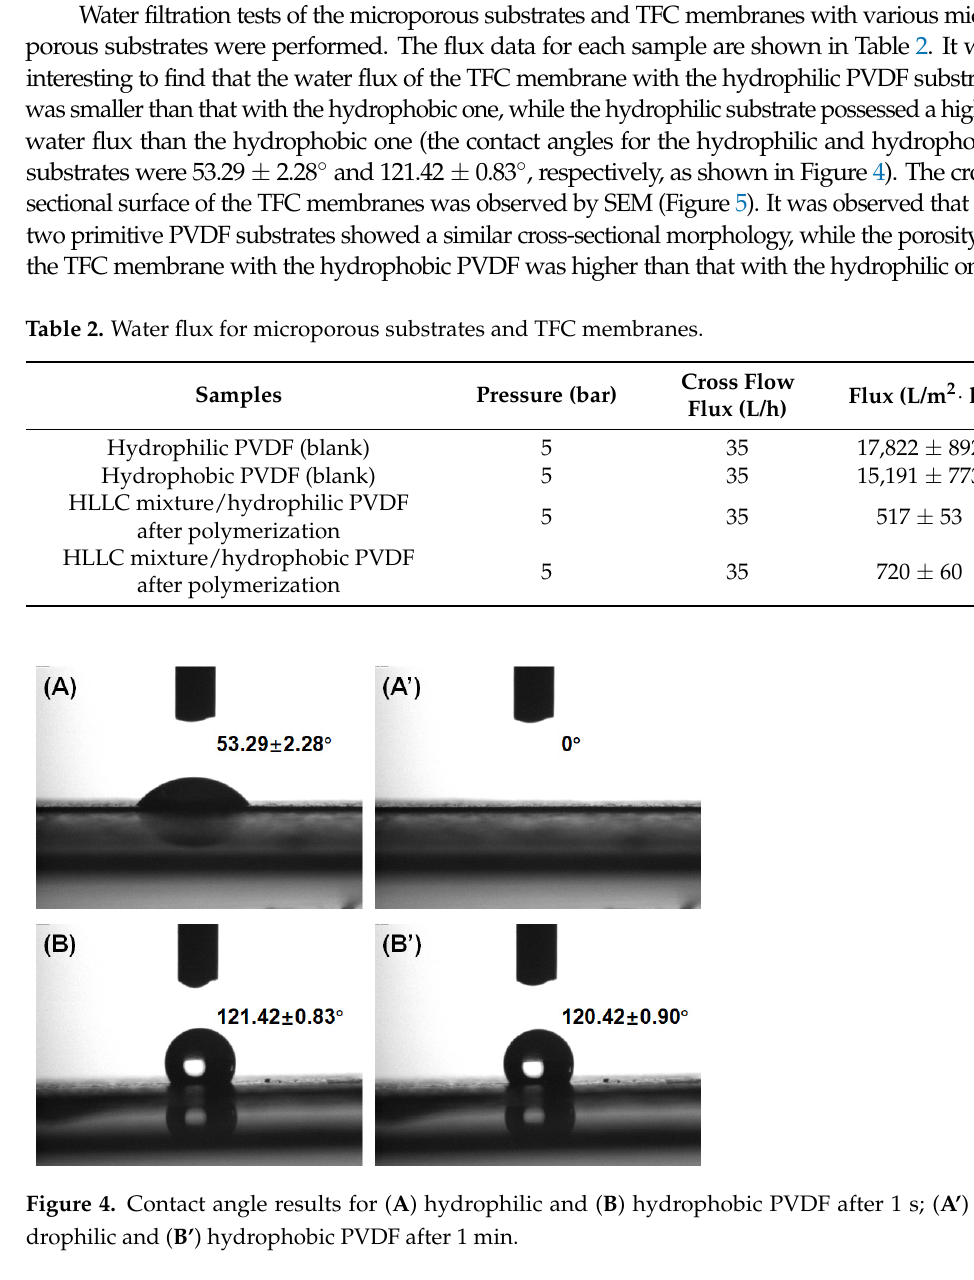
Figure 5. Scanning electron micrographs of HLLC mixture on ( A ) hydrophilic and ( B ) hydropho- bic PVDF after polymerization; ( A’ , B’ ) are primitive hydrophilic and hydrophobic PVDF sub- strates, respectively. 3.3. Discussion In general, the pore size, surface hydrophilicity, thickness, and porosity determined the water flux of the TFC membranes. The pore size of the HLLC nanoporous active layer dominated the water flux of the TFC membranes. As there was no obvious difference in the HLLC structure after polymerization on both hydrophilic and hydrophobic PVDF substrates, the pore size of the active layer, therefore, had insignificant effects on the water flux of the TFC membranes. Since the HLLC mixture was infused into the substrate, the surface properties of the TFC membranes were, therefore, determined by the substrate to some extent. It is rational to expect that TFC membranes would exhibit higher water flux with a hydrophilic surface than with a hydrophobic one, but this is not in agreement with the results of this study, where that the higher water flux by using the hydrophobic sub- strate could not be ascribed to the hydrophilicity. Moreover, the TFC membrane with the